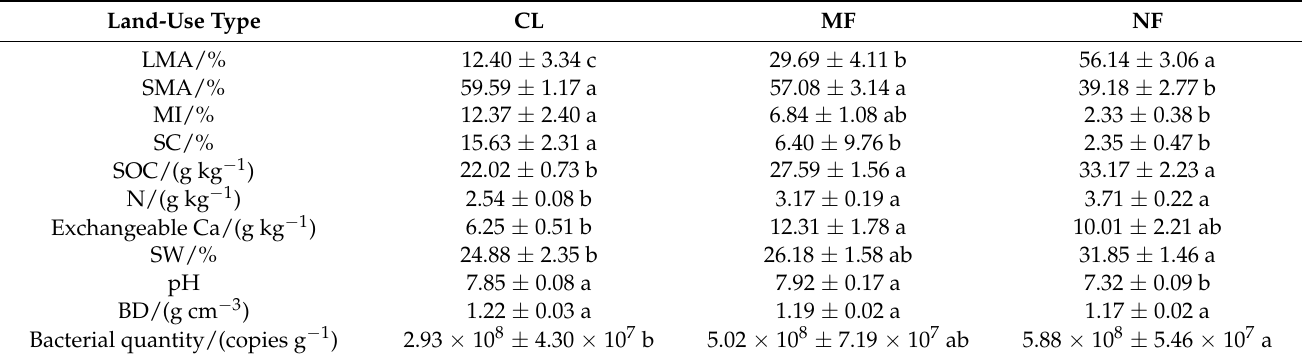
Table 1. ANOVA results showing the effects of afforestation on the soil physicochemical